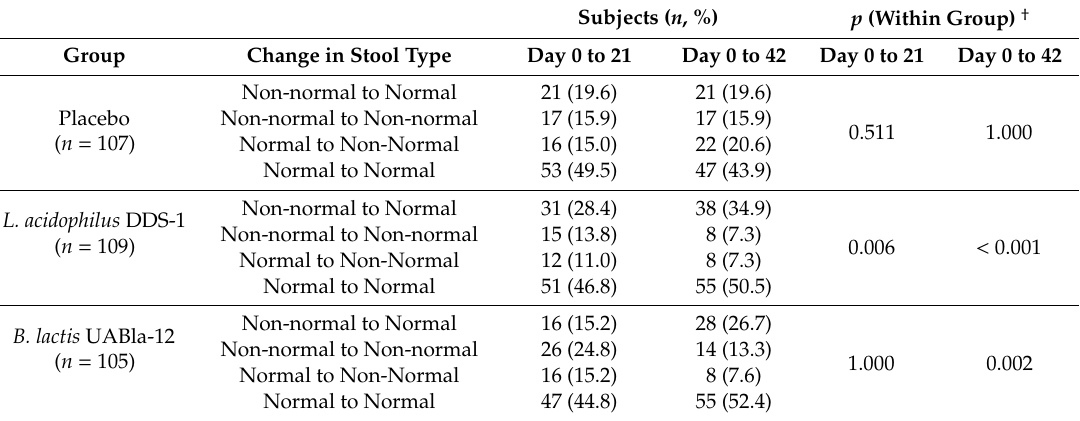
Table 5. Intragroup change in stool type over the intervention